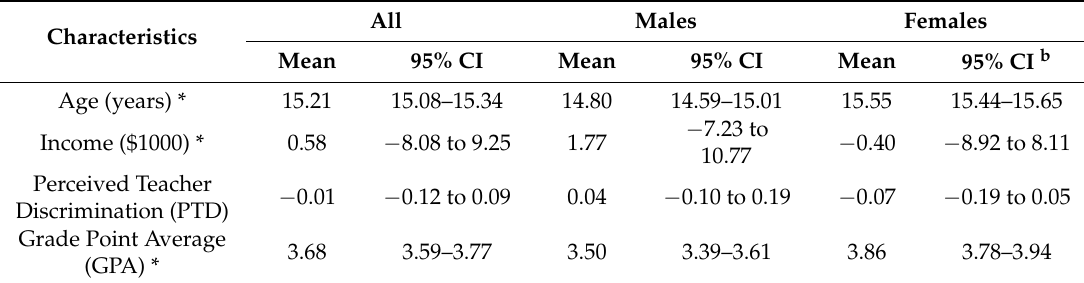
Table 1. Descriptive statistics among African American youth by